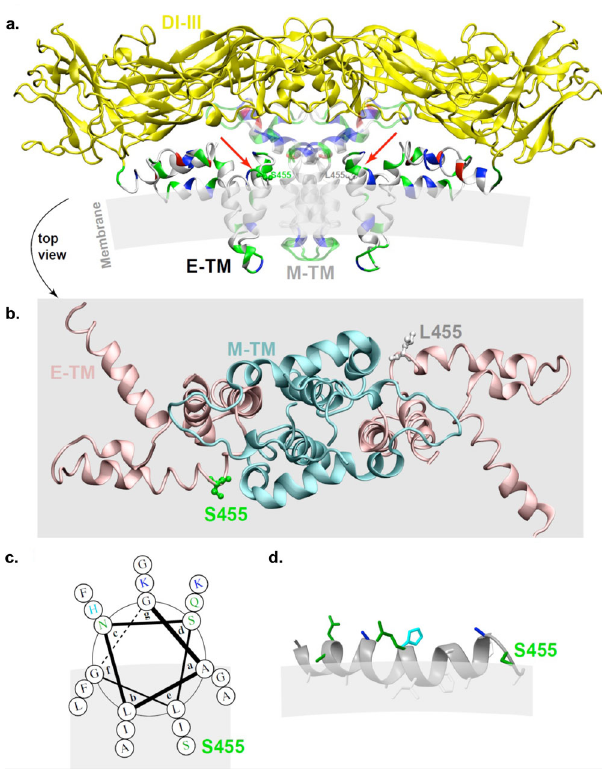
Fig. 6 Positioning of the S455L mutation in E structure. a Structure of ZIKA E (in solid) and M (transparent) proteins (5IRE.pdb) 42, 43 ,), with EI-III domains forming the envelope shell (yellow). The E and M protein transmembrane (TM) domains are shown with residue types indicated on the structure (white, hydrophobic; green, polar; blue, basic; red, acidic) in order to locate membrane insertion and to point out (red arrows) the positions of S455 (left monomer) and the mutant form L455 (right monomer) at the membrane interface. b Zoom of E-TM (cyan) and M-TM (pink), without EI-III, as viewed from the top of the structure shown in a . The positions of the wild-type S455 and mutant L455 residues at the interface between E and M TM domains are shown on one monomer each (the orientation of the L455 side chain is arbitrary), and has been created using the mutation tool in Swiss-PdbViewer. c Helical wheel (created with DrawCoil (http://www.grigoryanlab.org) of the helical segment with S455 indicated. The amphipathic helix is shown with the possible membrane bilayer in gray. d Side view of the helix with S455 located just above the membrane interface; mutation to L should drive deeper insertion of the helix into the